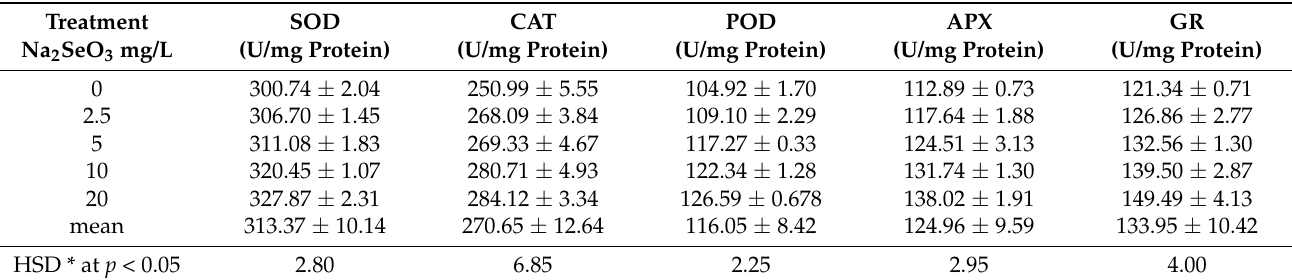
Table 4. Effect of various selenium levels (Na 2 SeO 3 ) on antioxidant enzyme activities of superoxide dismutase (SOD), catalase (CAT), peroxidase (POD), ascorbate peroxidase (APX), and glutathione reductase (GR) of quinoa plants after 30 days of selenium treatment. Number of samples 15:5 replications and 3 biological replicates. Treatment Na 2 SeO 3